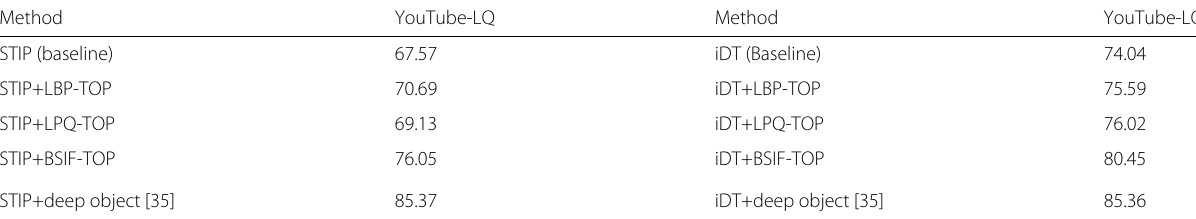
Table 3 Recognition accuracy (%) of various approaches on the Youtube-LQ dataset Method